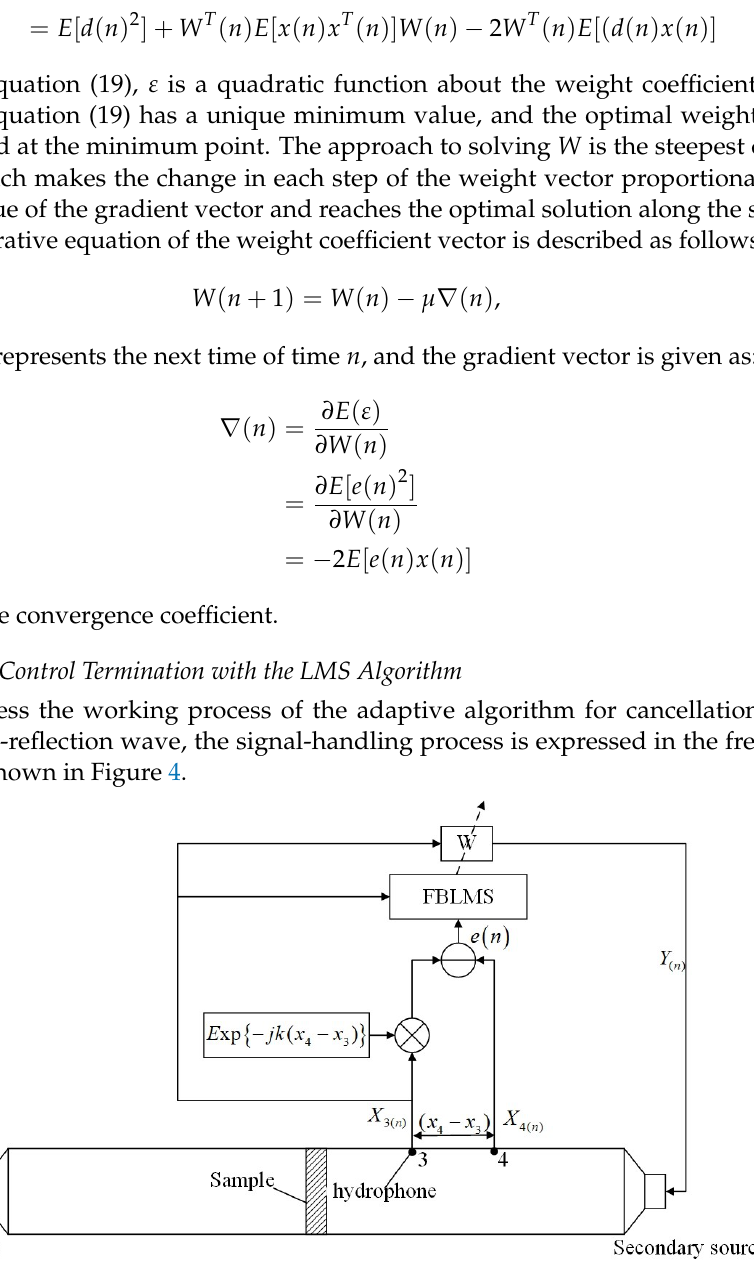
Figure 4. Signal-handling process of adaptive control